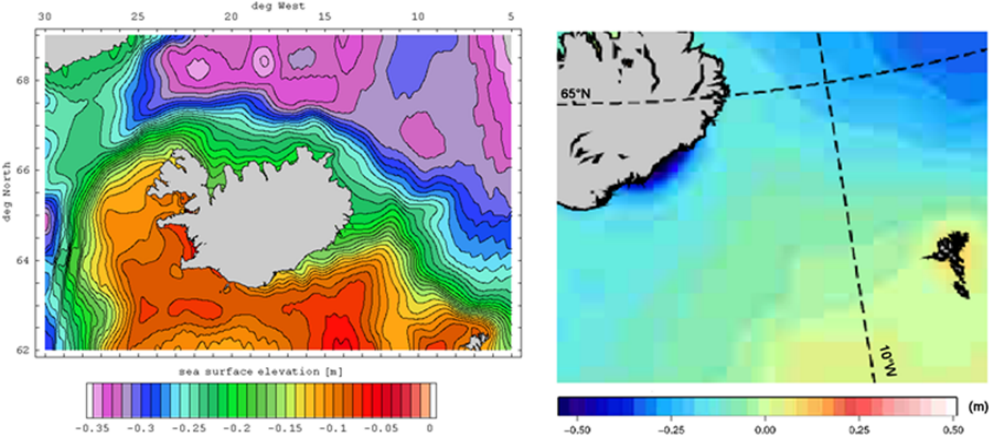
Fig. 20. Left: the simulated 1992–2006 mean sea surface elevation around Iceland. Right: the mean dynamic topography model of Huneg- naw et al. (2009) calculated from marine, airborne and satellite gravimetry, combined with satellite altimetry. Modified after Hunegnaw et al.